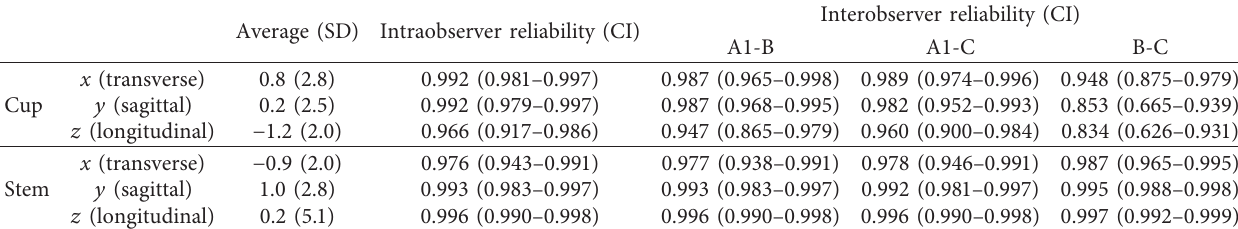
Table 4: Intraobserver and interobserver reliabilities for implant